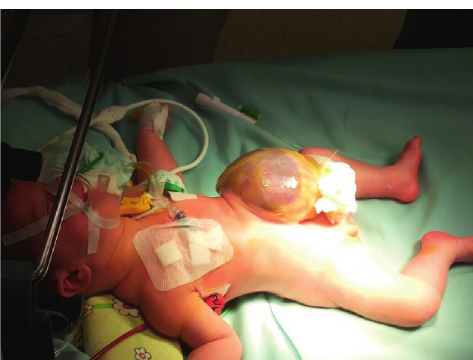
Figure 1: Giant omphalocele containing a significant portion of the liver.